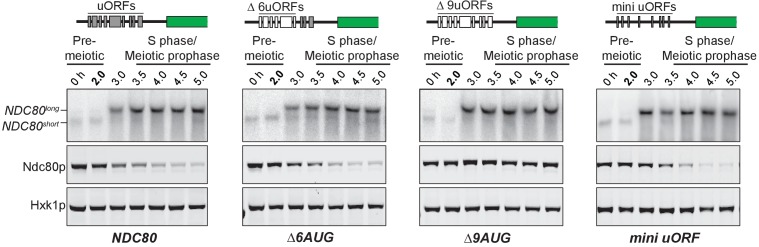
The longer NDC80 mRNA isoform is unable to synthesize Ndc80 protein due to translation of its AUG uORFs.(A) NDC80short, NDC80long, and Ndc80 abundance during synchronous meiosis (as described in Figure 2B) in wild type (UB6190), Δ6AUG (UB6181), Δ9AUG (UB6183), and mini uORF (UB9243) strains. In the Δ6AUG and Δ9AUG strains, the first 6 or 9 uORF AUGs in the 5’ leader of NDC80long were converted to AUCs, respectively. The mini uORF construct contained all 9 uORF start sites in the NDC80long leader; however, the third codon of each of the 9 uORFs was mutated to a stop codon. One of the two repeated experiments is shown.